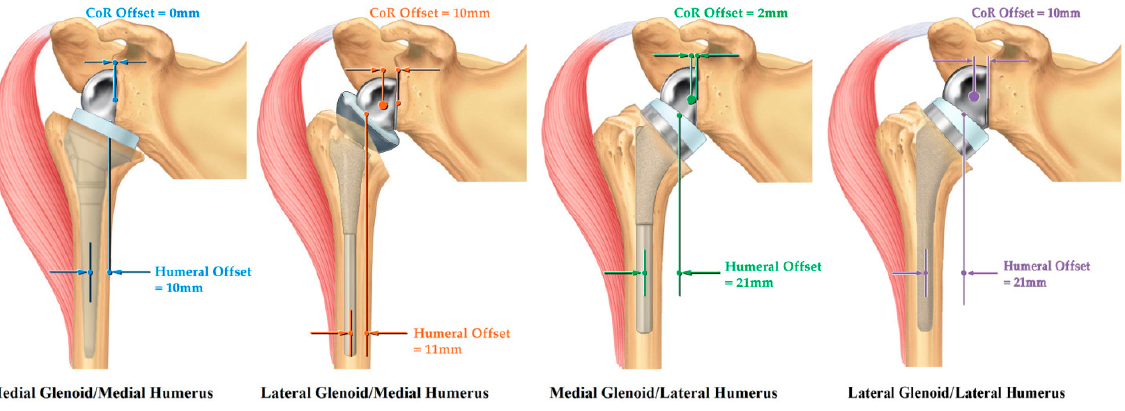
Figure 8. rTSA prosthesis design classification. The MG/MH reverse shoulder prosthesis is the Grammont Delta III prosthesis and is associated with the most medial positioning of the CoR and the humerus. Because of